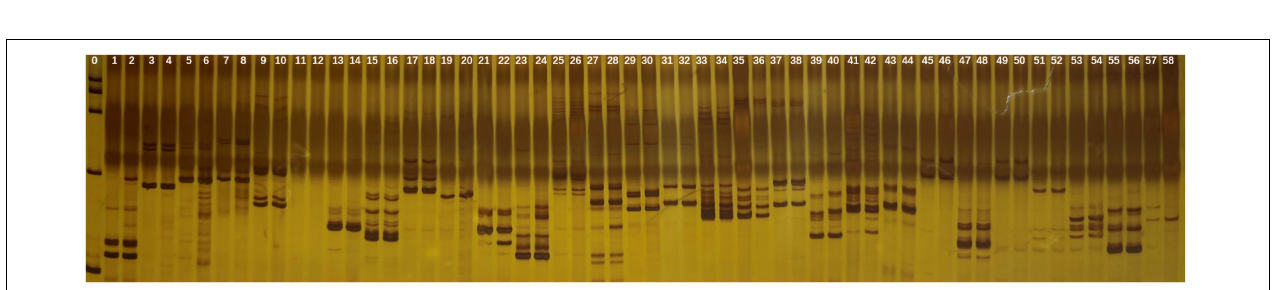
FIGURE 3 | SSR banding pattern in the tetraploid and diploid garlic plantlets by 29 primers. Lane 0: marker, odd lane: diploid garlic, even lane: tetraploid garlic.